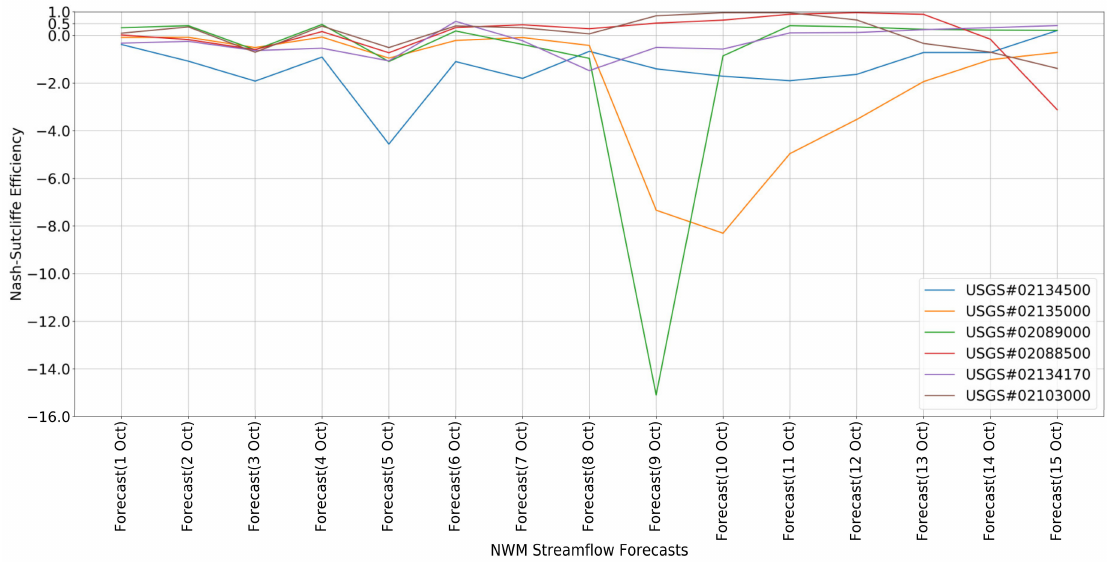
Figure 4. Nash–Sutcli ff e ffi ciency coe ffi cients for comparing the National Water Model (NWM) forecast streamflow with the United States Geological Survey (USGS) observed streamflow.